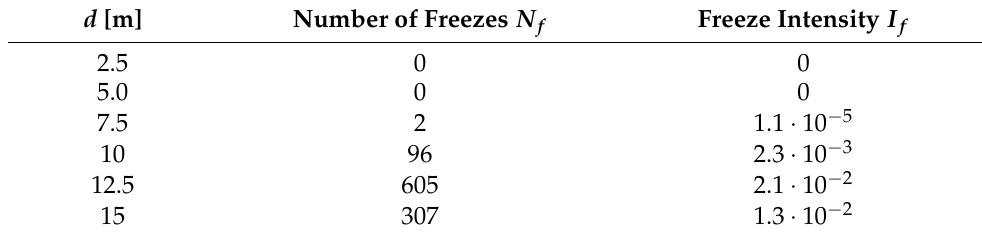
Table 1. Number of freezes and freeze intensity accumulated over all quadrants.